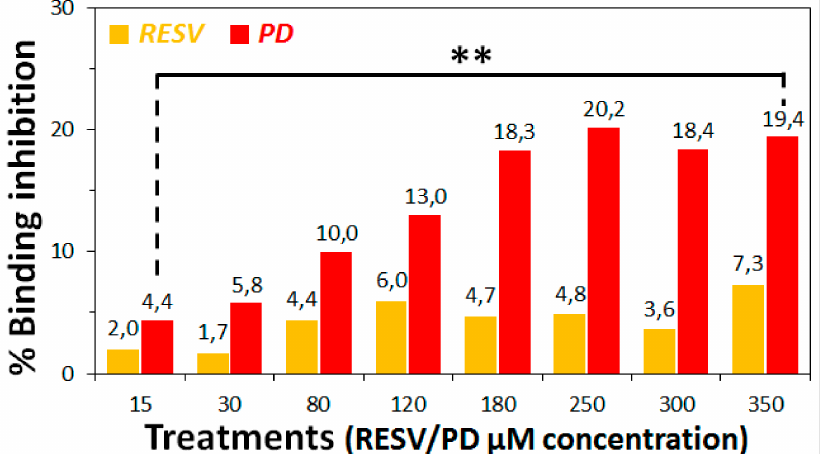
Figure 6. ACE2:Spike inhibition binding assay. In all treatments, the polyphenols were pre-incubated with Spike in solution. Chemiluminescence intensities were measured on the 96-well plate with a luminescence reader and converted in percentages of ACE2:Spike-binding inhibition with respect to the positive control. p -values have been calculated using the Student’s t -test (** p ≤ 0.01). Analysis of these data evidenced that the highest effect was obtained at 250 µ M PD concentration, with a binding-inhibitory activity of ca.